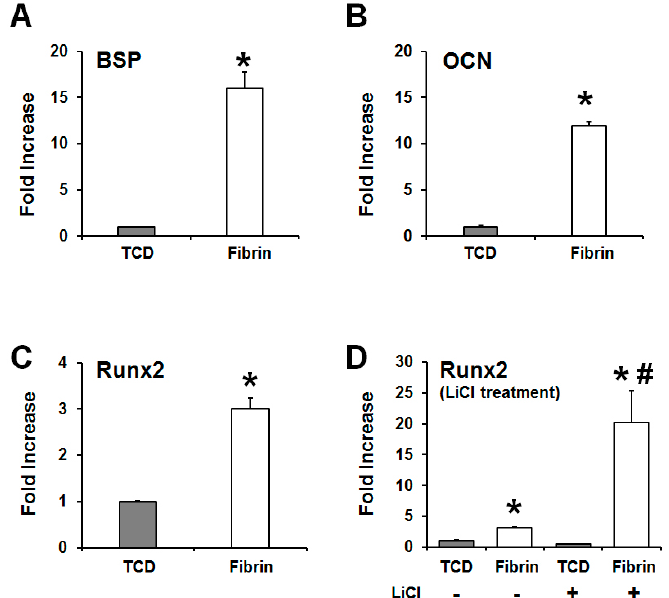
Figure 2. Activation of canonical Wnt signaling in OCCM30 on fibrin and the promotion of the expression of biomineralization-associated molecules. OCCM-30 cells were cultured on TCD (OCCM30-TCD) and fibrin matrices (OCCM30-fibrin) to accelerate cementoblast differentiation for three days. Using quantitative real time PCR, biomineralization-associated molecules had higher expression levels in the fibrin matrices; alkaline phosphatase (ALP; ( A )), Osteocalcin (OCN; ( B )), runt-related gene 2 (Runx2; C ), and Runx2 with/without the LiCl treatment ( D ). All biomineralization-associated factors can be highly expressed in OCCM30-fibrin with statistically significant differences ( A – C ). Particularly, despite the intentional activation of the canonical Wnt signaling by the LiCl treatment, LiCl-treated OCCM30-TCD showed lower Runx2-expression level than OCCM30-fibrin (without the LiCl treatment; ( D )). They were normalized to mRNA levels of glyceraldehyde-3-phosphate dehydrogenase (GAPDH) and indicated by fold increase. Each experiment was repeated two times independently. * Significantly different from the OCCM30-TCD groups ( p < 0.05), # significantly different from LiCl non-treated group ( p < 0.05).